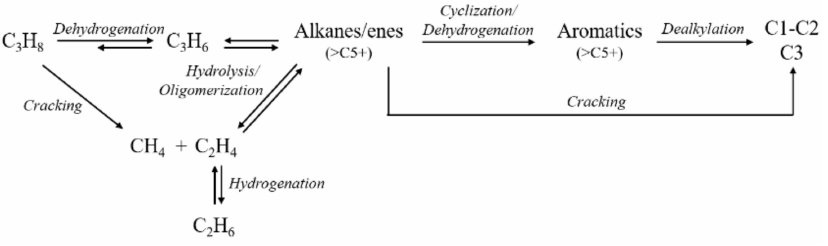
Scheme 1. Plausible acid-catalyzed reaction pathways of propane